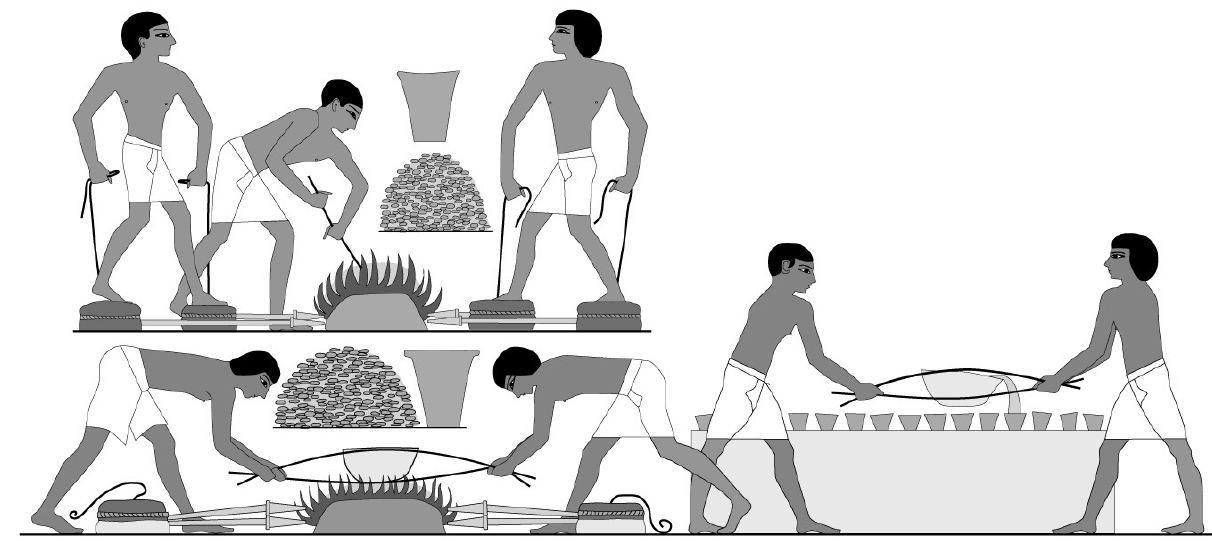
Figure 6. Preparation of Bronze (heating by means of foot